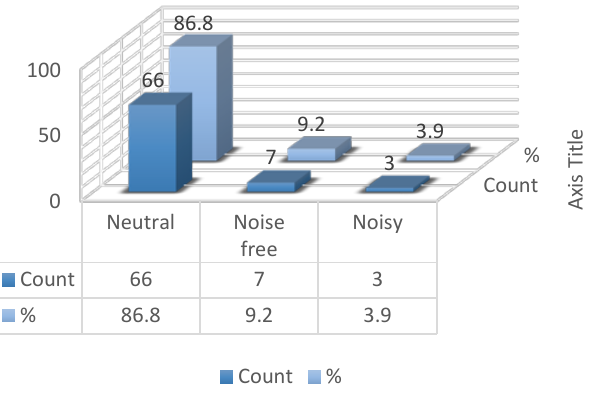
Figure 9. Environmental conditions used in the studies.